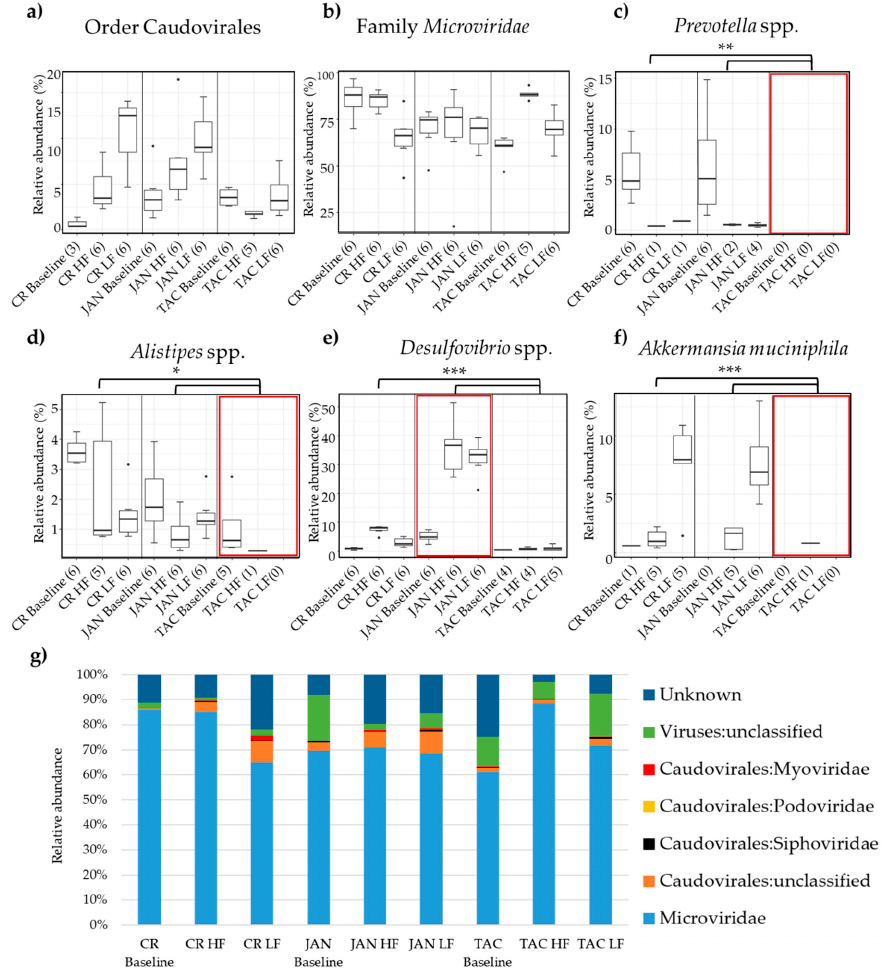
Figure 4. Relative abundance of ( a ) the order Caudovirales and ( b ) the family Microviridae . Differences in the relative abundance of Prevotella spp., Alistipes spp., Desulfovibrio spp., and Akkermansia muciniphila between vendors and diet are illustrated in respectively ( c ), ( d ), ( e ), and ( f ). The most abundant viral taxonomies are illustrated by bar plots in ( g ). The parentheses show the number of samples from each group included in the plot. Black dots indicate outliers and the red boxes mark the vendor with interesting differences in bacterial abundance. Black branches and stars mark the significant bacterial differences in abundance between vendors, * = p < 0.05, ** p < 0.005, *** p < 0.0005 based on pairwise Wilcoxon rank sum test. Abbreviations: LF = low-fat diet, HF = high-fat diet, CR = Charles River, JAN = Janvier, TAC = Taconic.